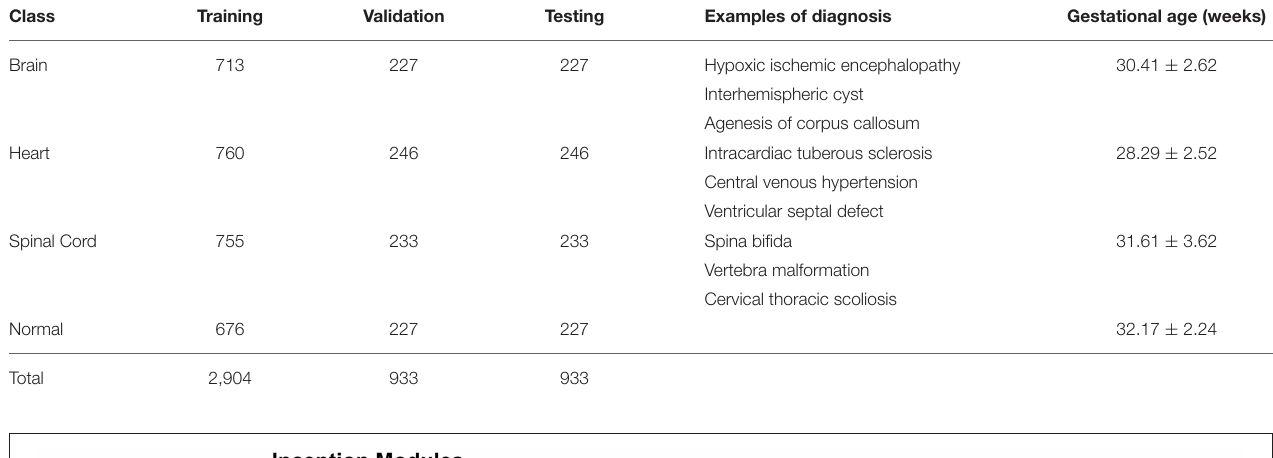
TABLE 1 | Detailed evaluation of the fetal MRI dataset, training and validation, and examples of diagnoses.